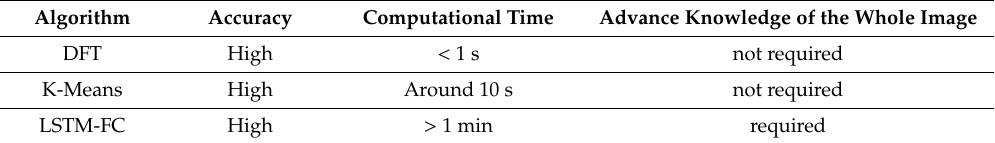
Table 1. Comparison of performance indicators of the three di ff erent algorithms presented in the paper. Algorithm Accuracy Computational Time Advance Knowledge of the Whole Image DFT High < 1 s not required K-Means High Around 10 s not required LSTM-FC High > 1 min